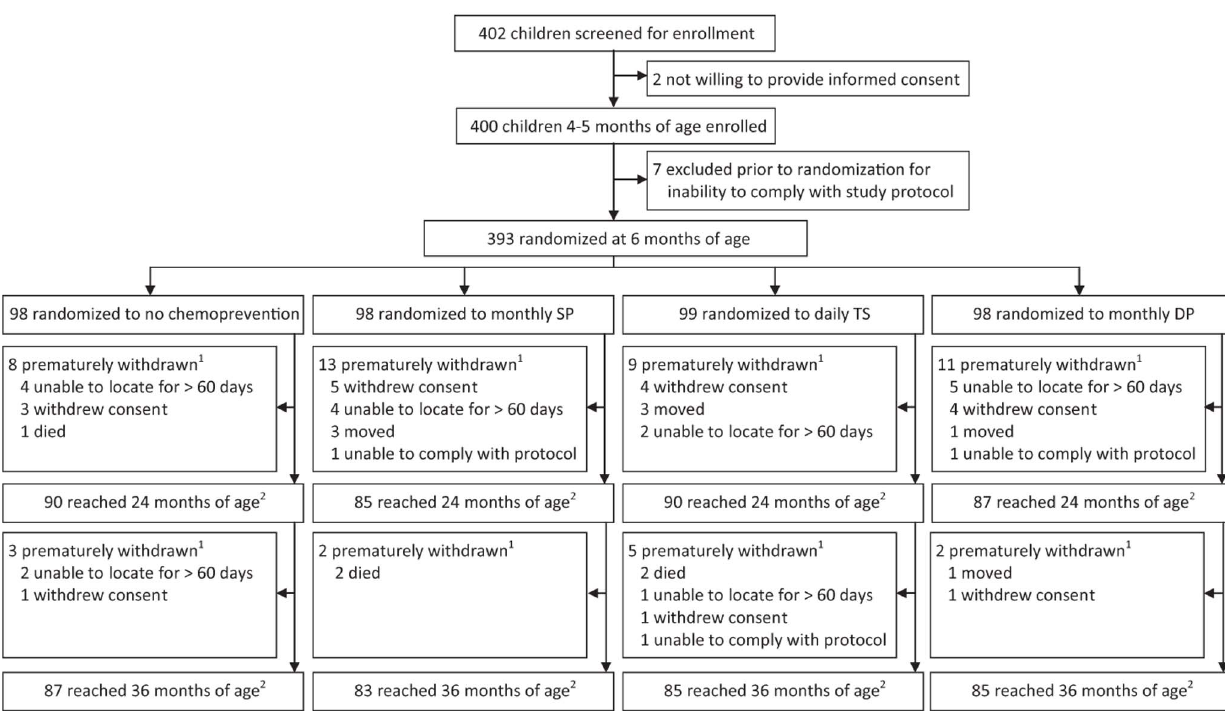
Figure 1. Trial profile. 1 Only data that accrued until the study participant was prematurely withdrawn from the study were included in the modified intention-to-treat analysis. 2 Complete data included in the modified intention-to-treat